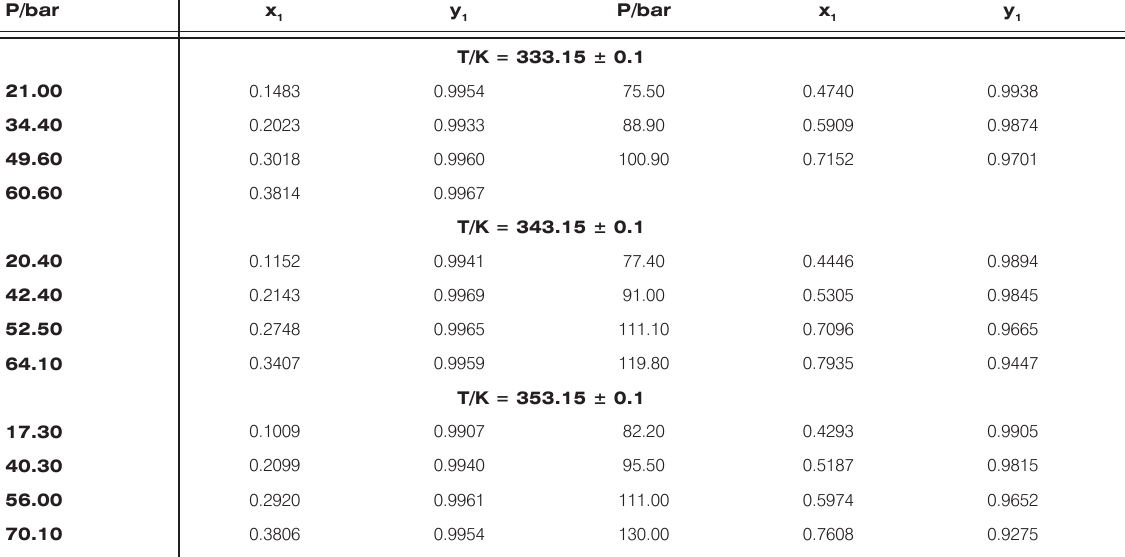
Table 2. Mole fractions of component 1 in the liquid phase x and mole fractions of component 1 in the vapor phase y 1 P and temperatures T for the binary system carbon dioxide (1) + 2-methyl-1-propanol (2). P/bar x y 1 1